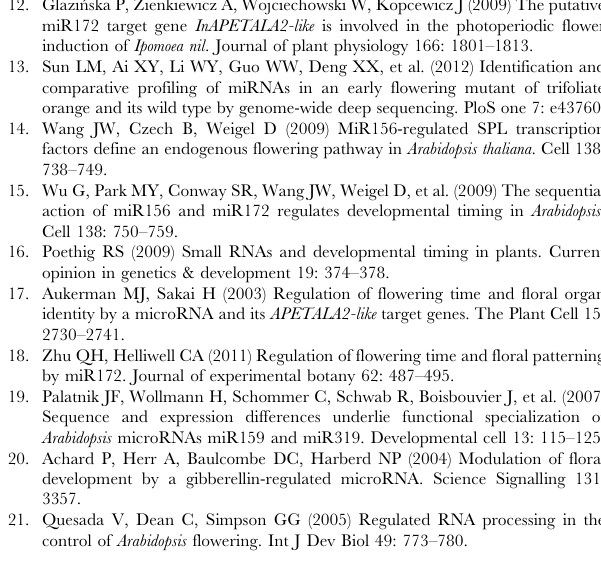
shown in red, while the corresponding miRNA* sequences are shown in blue. (TIF) Figure S3 The miRNA targets involved in plant circadi- an rhythms according to a KEGG pathway analysis. The homologs of photoperiodic flowering genes as indicated by red boxes are shown with a blue bracket. (TIF) Table S1 The primers used in this study. (XLSX) Table S2 Known rice miRNAs expressed in the common wild rice from our HTS datasets. Table S3 Newly identified miRNAs in the common wild rice from our HTS datasets. Table S4 Flowering targets prediction of flowering miRNAs from our HTS datasets. Table S5 Difference expression analyses of flowering miRNAs among the 3 libraries respectively. Table S6 The different expression of flowering miRNAs among the 3 libraries respectively